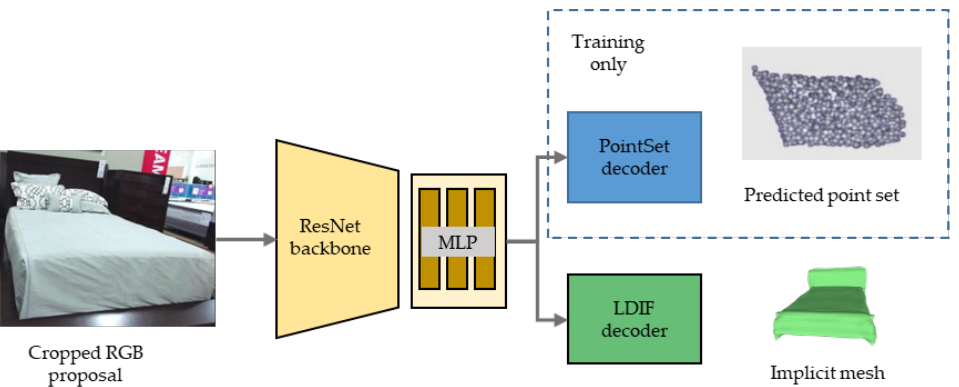
Figure 3. Architecture of the mesh reconstruction network. The Mesh reconstruction network outputs shapes in two different representations to encourage ResNet and MLP to extract features that contain the necessary information for both representations.